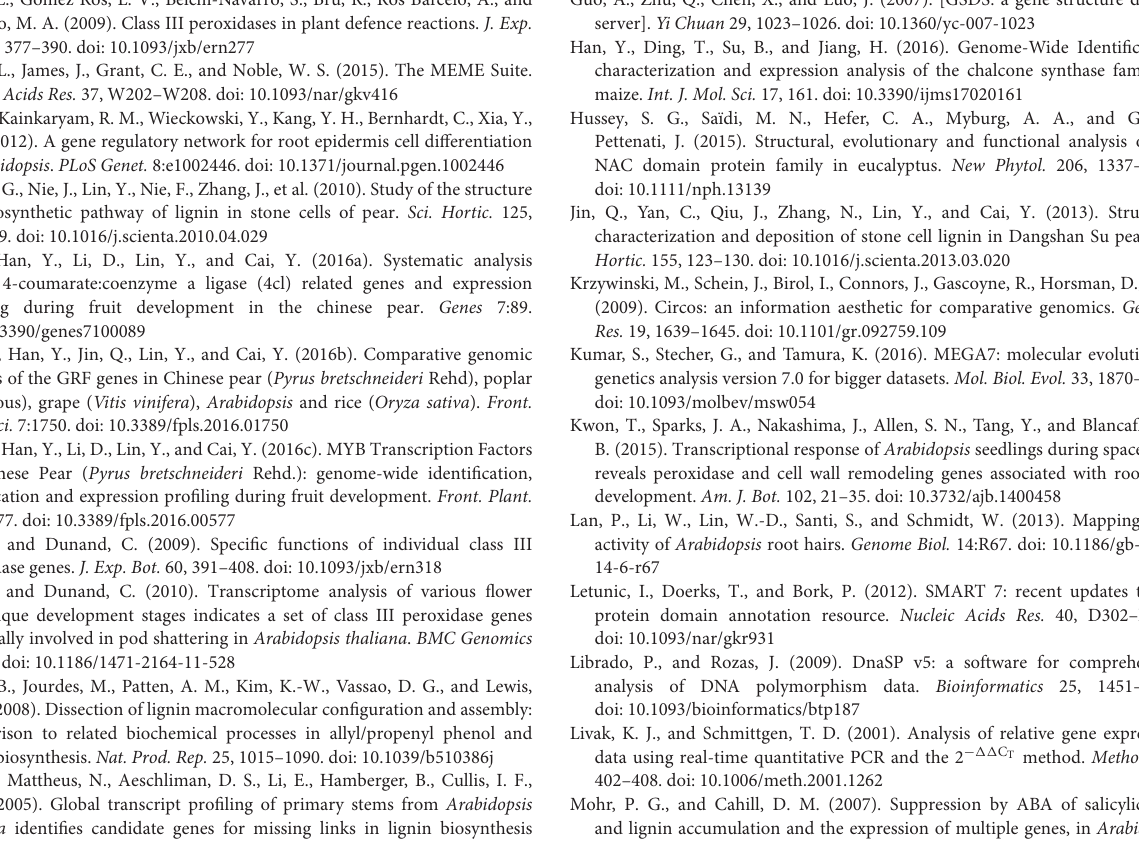
Figure S1 | Phylogenetic tree reconstruction of PRX proteins. The PRX proteins from the pear, yang mei, peach and strawberry were aligned using Clustalw software, and the neighbor-joining tree was constructed by MEGA7.0 software, with1000 bootstrap replicates. Figure S2 | Sliding window plots of duplicated PRX genes in pear. The window size is 150bp, and the step size is 9 bp. The positions of the PRX domain were represented by gray blocks, respectively. Table S1 | Primers in this study. Table S2 | The detailed information of PRX genes in pear. Table S3 | All MEME motif sequences in pear PRX proteins.